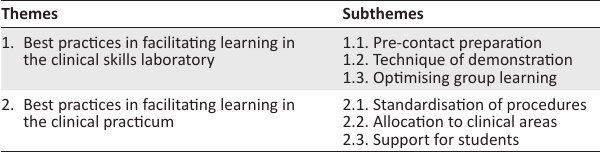
TABLE 1: Themes and